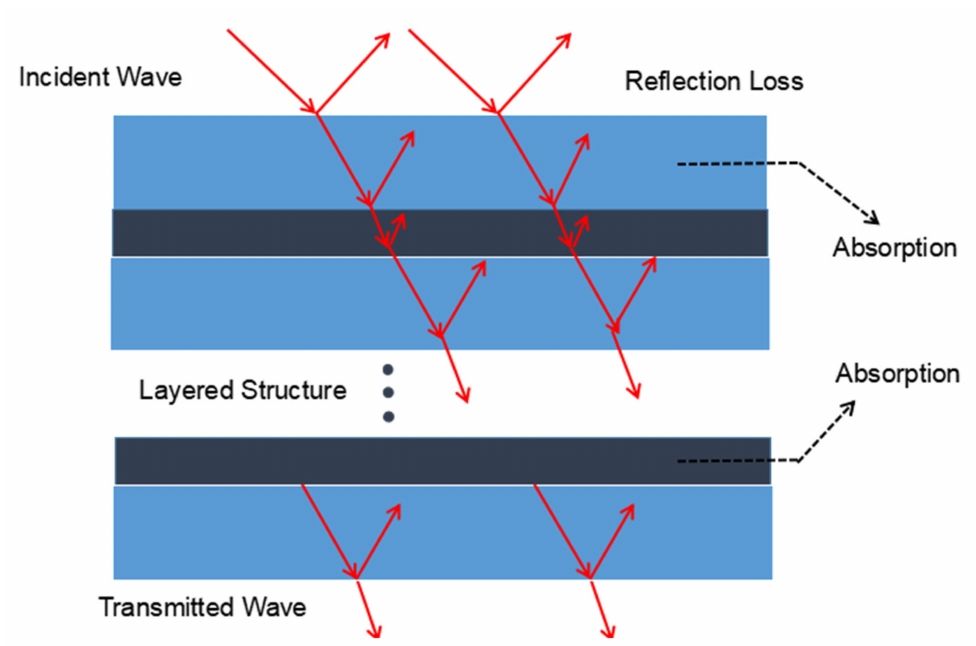
Figure 10. The electromagnetic shielding mechanism of the layered